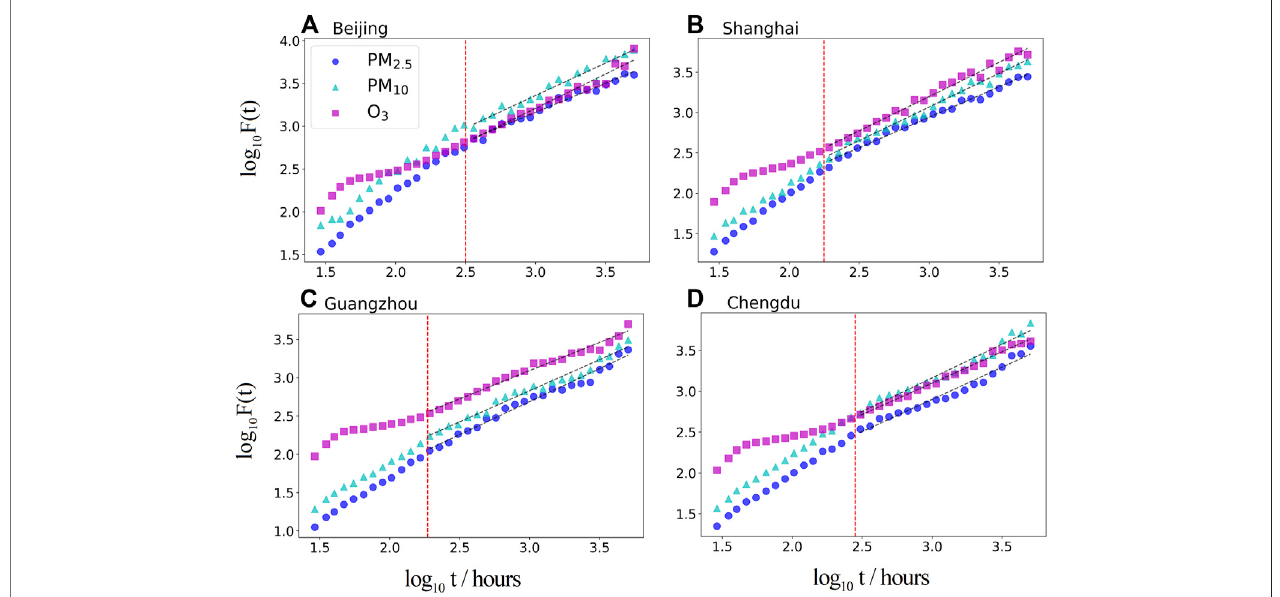
FIGURE 3 | (color online) The DFA analysis in summer for (A) Beijing, (B) Shanghai, (C) Guangzhou, and (D) Chengdu. Black dashed lines are fi tted power-law curves. Red dashed lines represents the location of the crossover point s x of AR (1) processes with different parameters a .